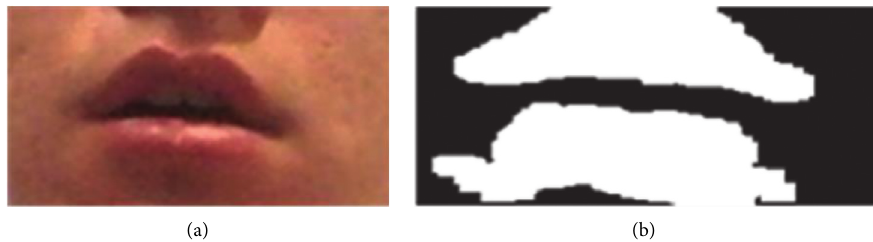
Figure 8: Mouth processing. (a) Open mouth sample. (b) Flat structuring element.